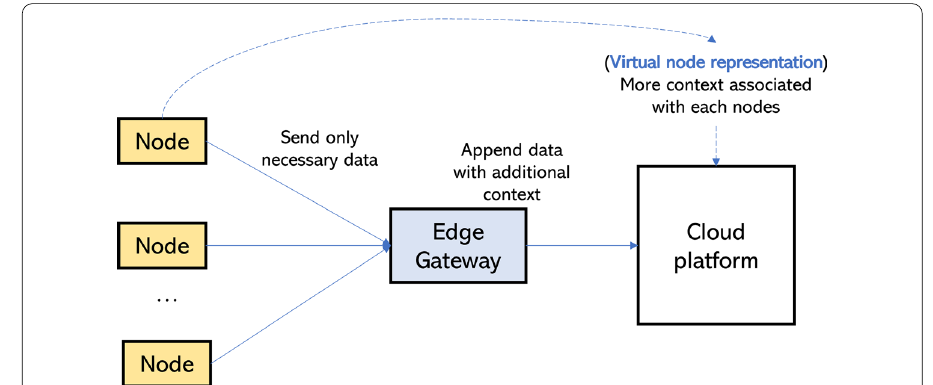
Fig. 17 Considering context in the proposed